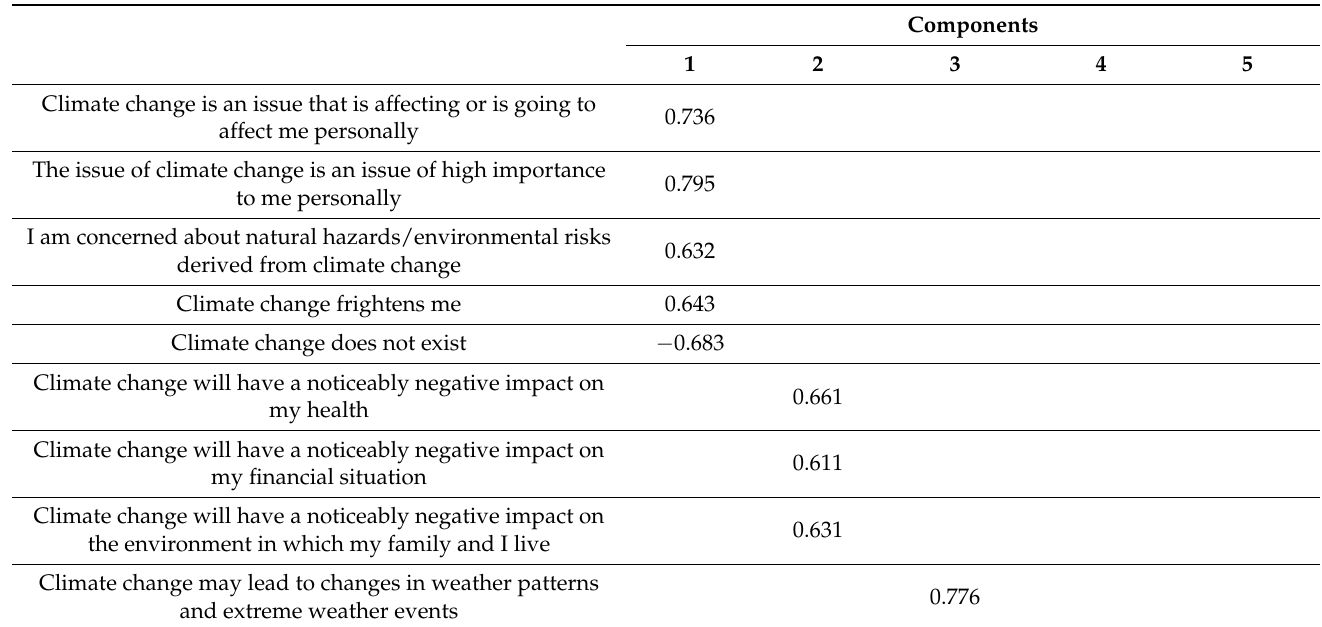
Table A2. Risk perception of climate change and natural disasters